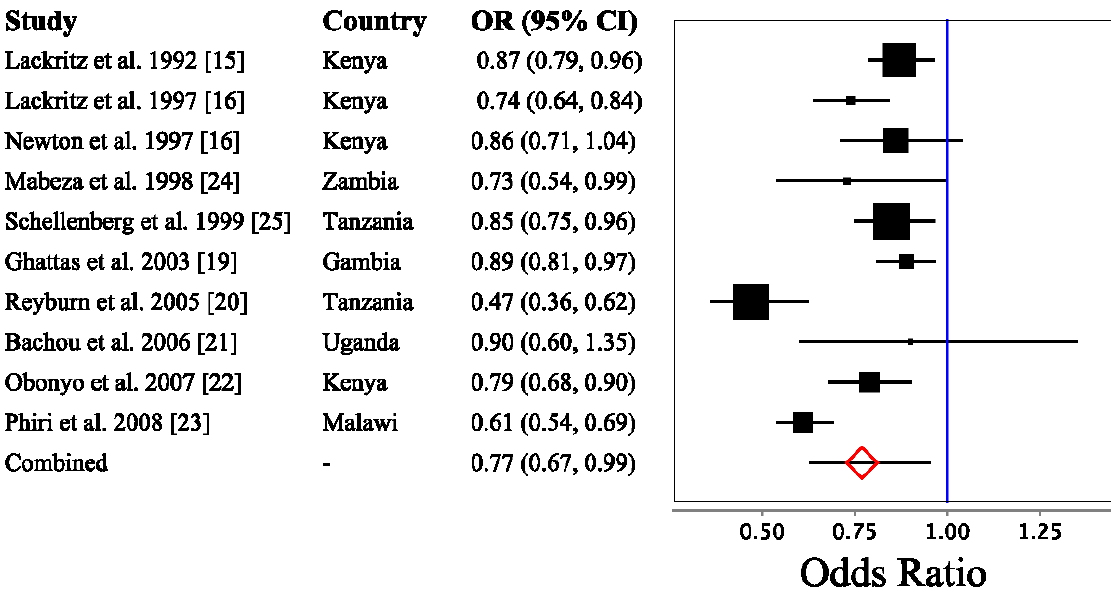
Figure 2. Estimated odds of death associated with a 1-g/dL increase in